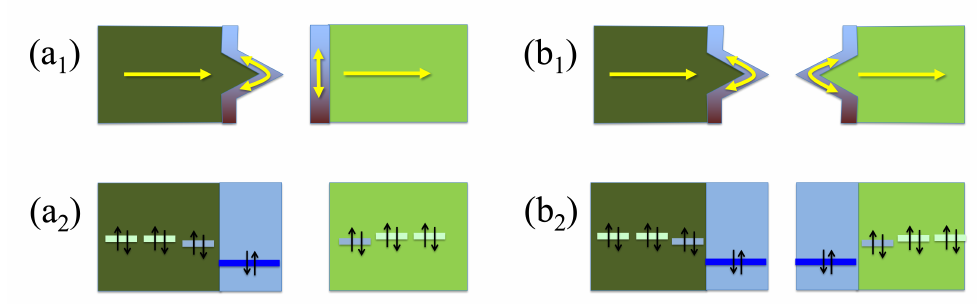
Figure 1. Schematic representation of the wedge–edge ( a ) and wedge–wedge ( b ) configurations. The top panels (1) show a physical representation of electrons flowing through 2D layers due to a bias voltage or a temperature gradient and the electrons on the edge states, which do not couple to the former when their group velocity is perpendicular; the bottom panels (2) show the corresponding levels of the tight-binding